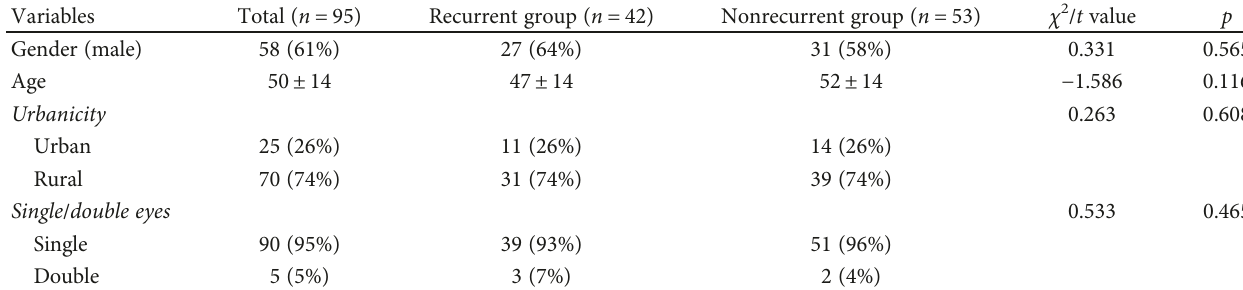
Table 1: Demographics of